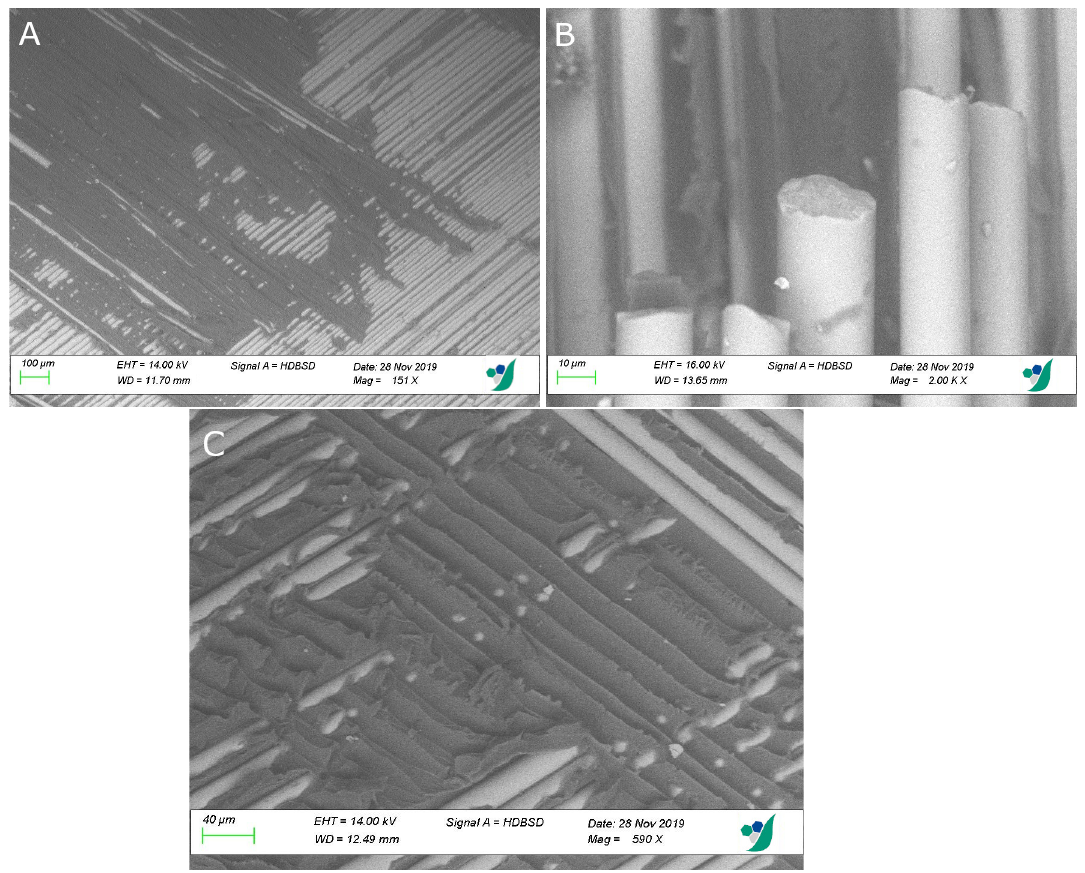
Figure 6. Scanning Electron Microscope (SEM) images of the fractured shear sample show large areas of bare fibers ( A ) and, on a closer look, bare fibers without matrix leftovers ( B ). These results indicate, together with the fiber debonding marks in ( C ), that the fiber-matrix interface is